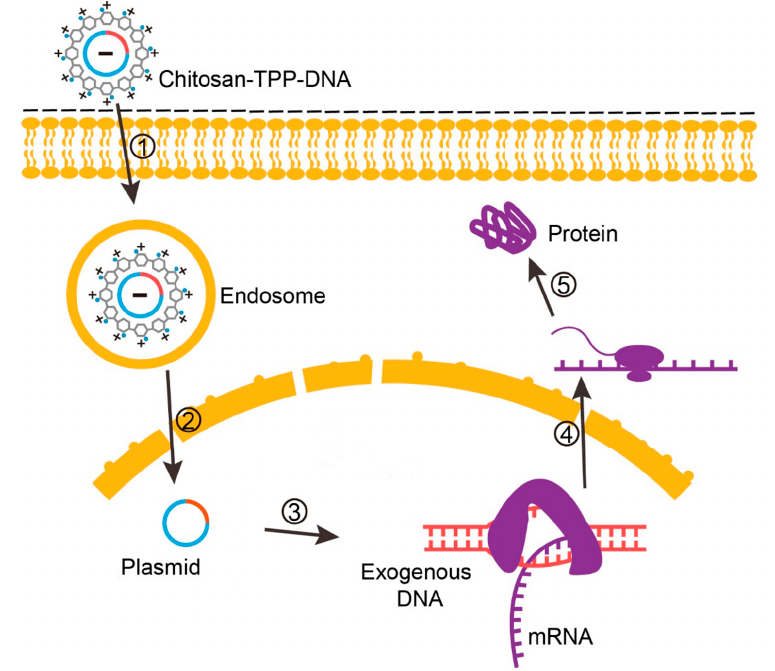
Figure 4. Cellular events associated with chitosan-based plasmid delivery for exogenous gene expression. 1, Cellular uptake of chitosan–DNA by endocytosis. 2, Endosomal escape of the chitosan–DNA complex, plasmid dissociation from chitosan and translocation to the nucleus. 3, Transcription of plasmid (exogenous DNA) in the nucleus and mRNA generation. 4, Translation of newly transcribed mRNA in the cytosol. 5, Exogenous protein assembly.